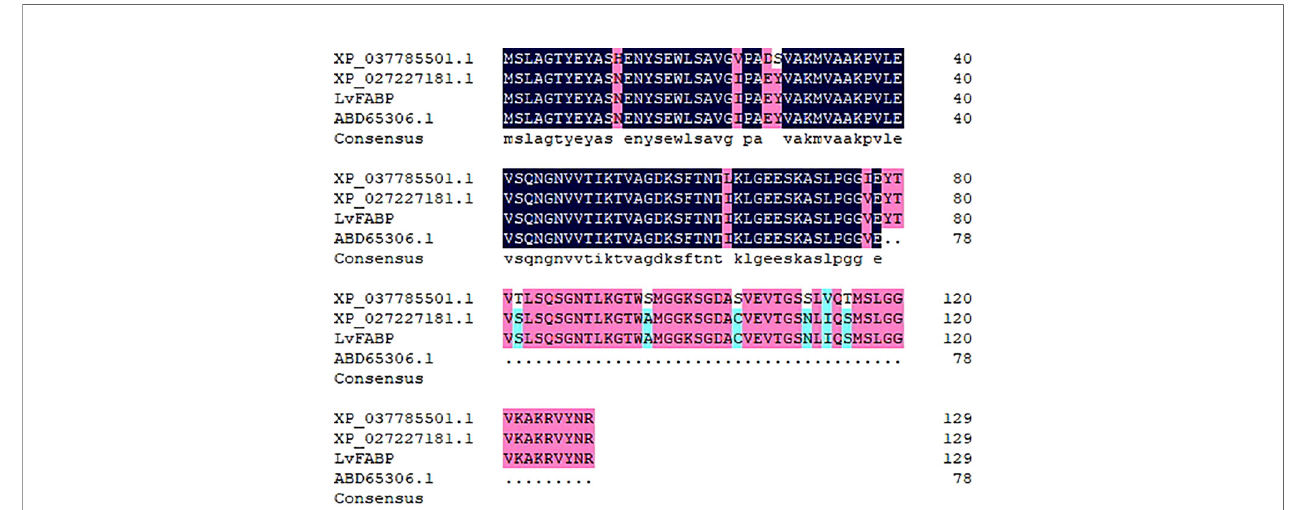
FIGURE 1 | Multiple sequences alignment of LvFABP. The black columns indicated completely identical amino acid zones, the red columns indicated ≧ 75% identical amino acid zones, the blue columns indicated ≧ 50% identical amino acid zones. The percent identity between LvFABP and the fatty acid binding protein 10 isolated from Penaeus vannamei (ABD65306.1) was 78%; The percent identity between LvFABP and the fatty acid binding protein 1-B.1-like isolated from Penaeus monodon (XP_037785501.1) was 90%; The percent identity between LvFABP and the fatty acid binding protein 1-B.1-like isolated from Penaeus vannamei (XP_037785501.1) was